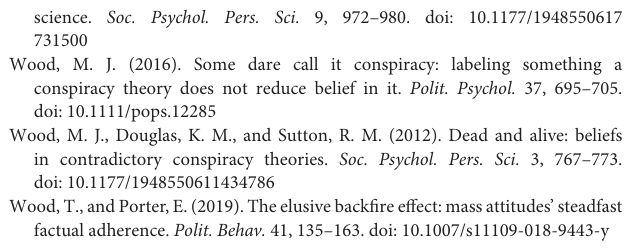
Wood,T.,andPorter,E.(2019).Theelusivebackfireeffect:massattitudes’steadfast factual adherence. Polit. Behav. 41, 135–163. doi: 10.1007/s11109-018-9443-y